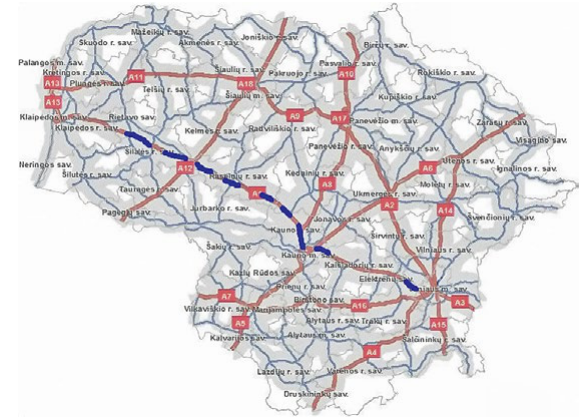
Fig. 5. The arrangement of average speed gauges on the left side of the road